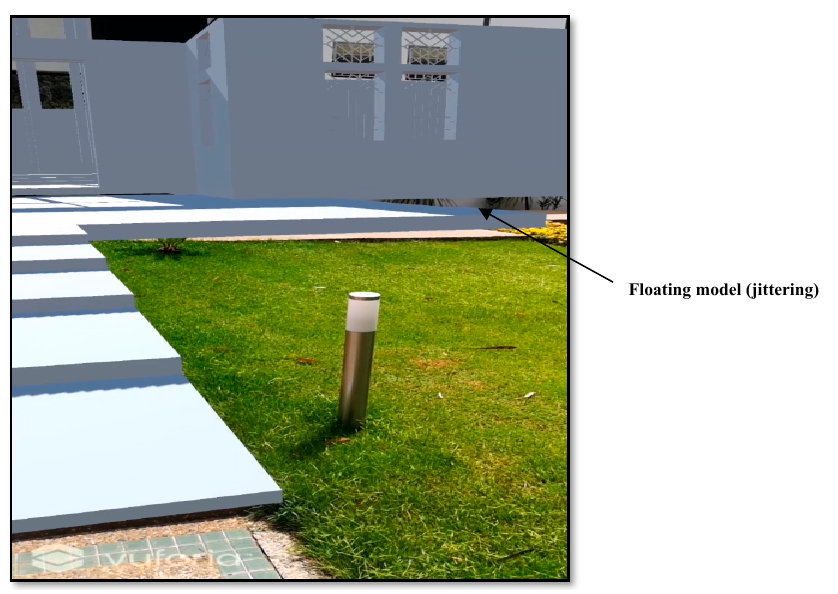
Figure 12. Degradation of virtual 3D model placement accuracy as we move away (10 m) from the marker (with Vuforia SDK).